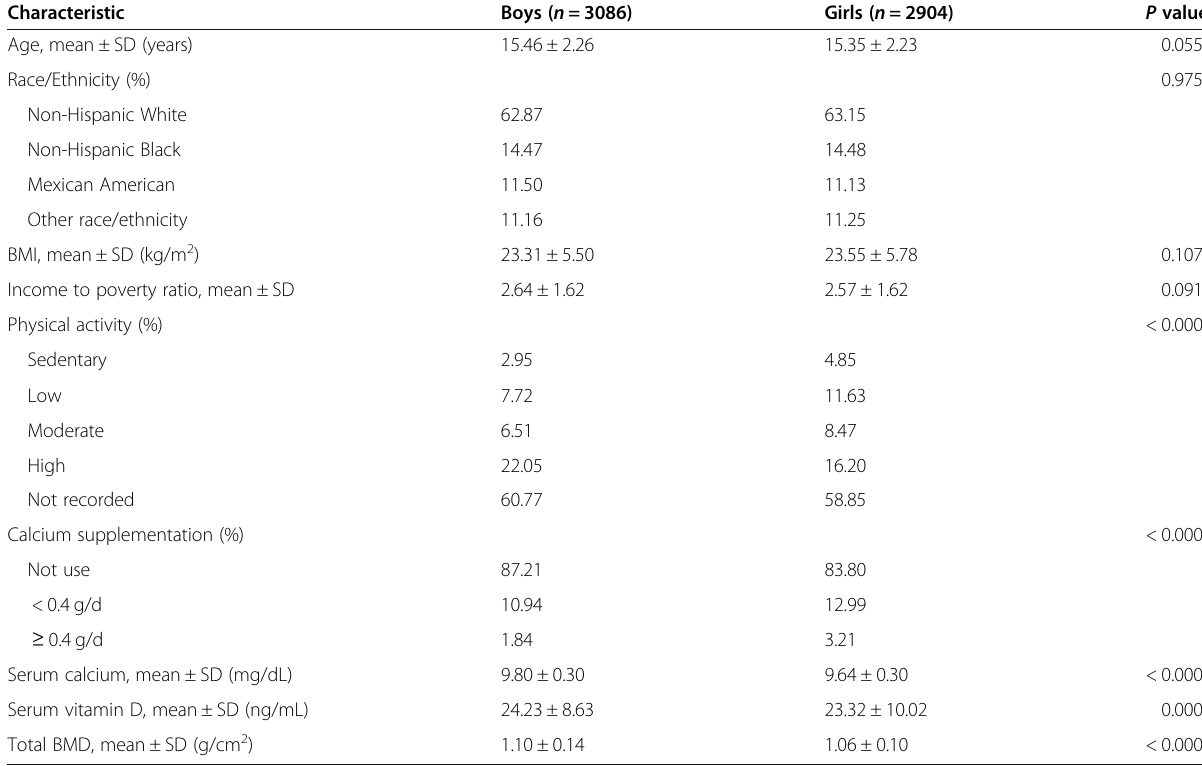
Table 1 Participant